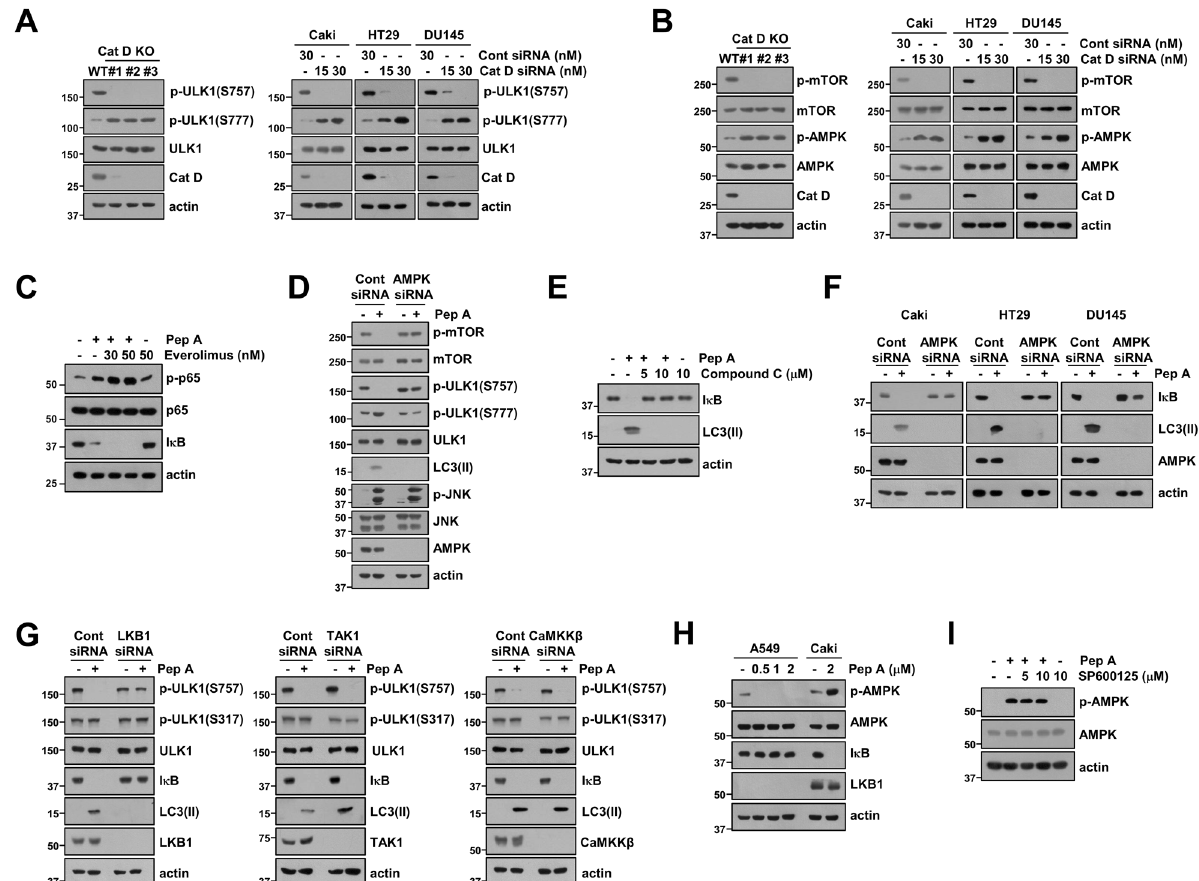
Fig. 5 LKB1/AMPK/ULK1 signaling pathway is involved in Pep A-induced autophagy fl ux. A , B Examination of protein expression in Caki/ Cat D WT and KO cells or Cont and Cat D siRNA-transfected cancer cells. C Caki cells were pretreated with the indicated concentrations of Everolimus, and 2 μ M Pep A was then added for 24 h. D Caki cells were transiently transfected with Cont siRNA or AMPK siRNA, and they were treated with 2 μ M Pep A for 24 h. E Caki cells were pretreated with the indicated concentrations of Compound C, and 2 μ M Pep A was then added for 24 h. F Cancer cells (Caki, HT29, and DU145) cells were transiently transfected with Cont siRNA or AMPK siRNA, and they were then treated with 2 μ M Pep A for 24 h. G Caki cells were transiently transfected with Cont siRNA, LKB1 siRNA, TAK1 siRNA, or CaMKK β siRNA, and they were treated with 2 μ M Pep A for 24 h. H A549 and Caki cells were treated with the indicated concentrations of Pep A for 24 h. I Caki cells were pretreated with the indicated concentrations of SP600125 for 30 min, and they were then treated with 2 μ M Pep A for 24 h. Protein expression was measured via western blotting ( A – I